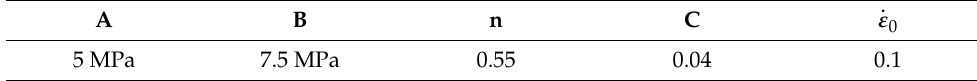
Table 1. Johnson–Cook plasticity model material parameters for PU20. A B n C